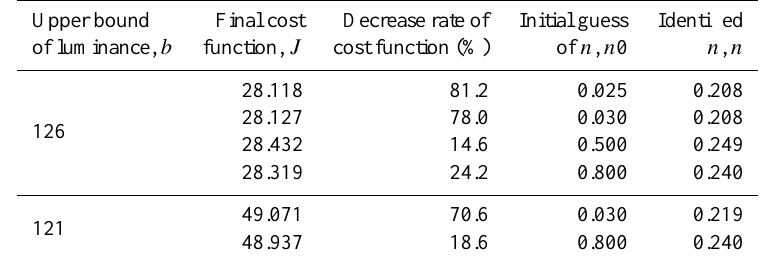
Table 5. The identified n and the final cost functions in the application to MFDA.